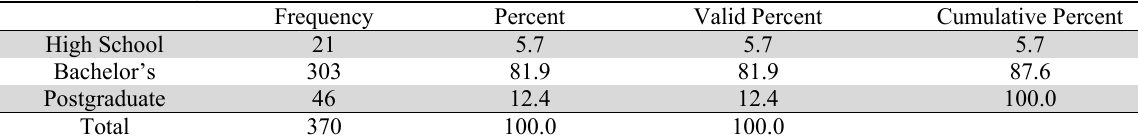
Educational background